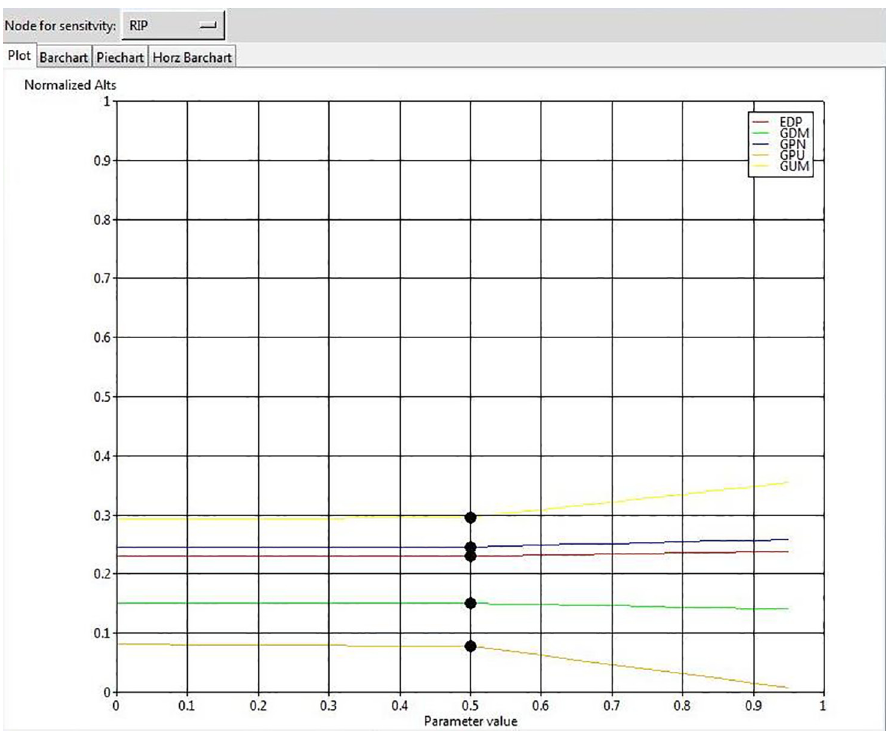
Fig 4. The results of sensitivity analysis for the node “ Regulatory Pressures ” .